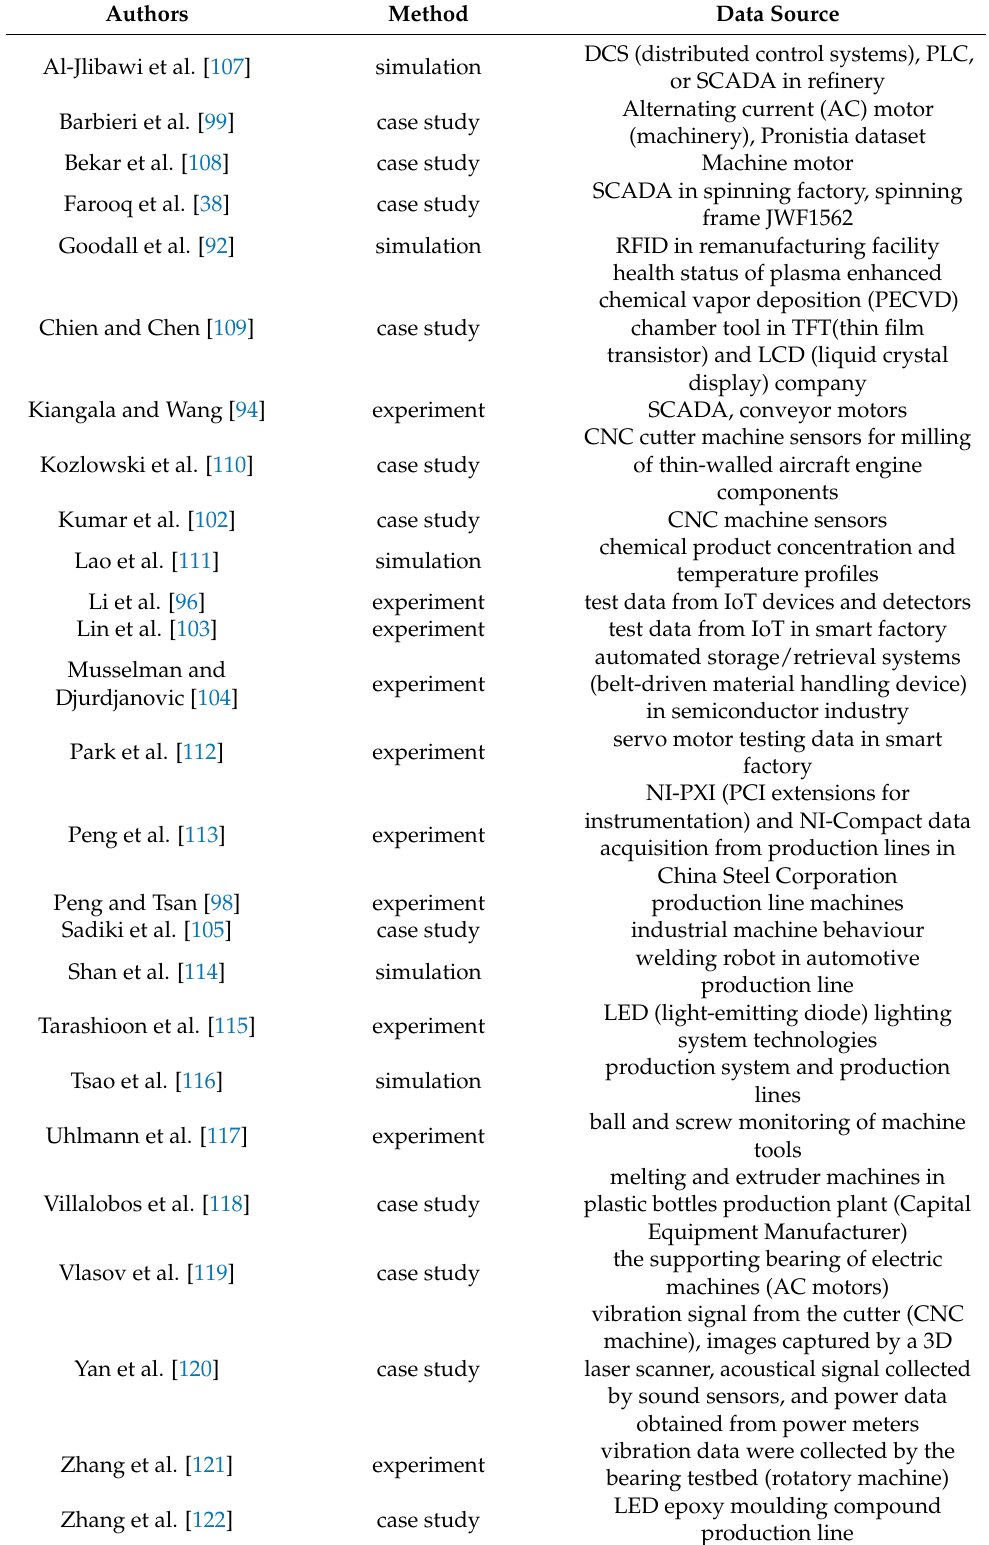
Table 8. Methods and sensors’